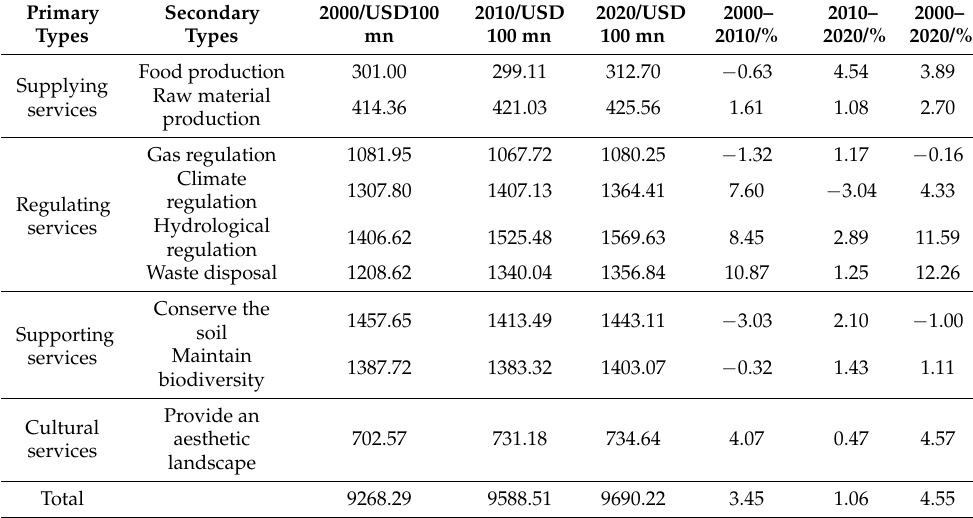
Table 6. Changes in the structure of ecosystem services between 2000, 2010, and 2020.